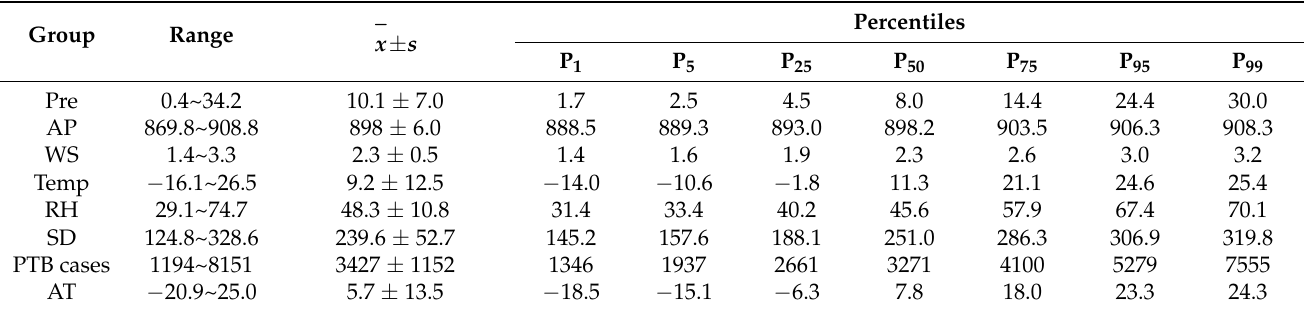
Table 1. Descriptive statistics for monthly PTB cases and meteorological factors in Xinjiang from 2004 to 2019.